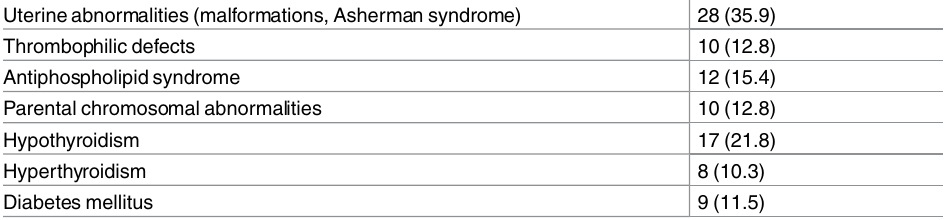
Table 1. Resultsof complete diagnosticevaluationin women withexplainedRM ( n = 78). Uterineabnormalities (malformations, Asherman